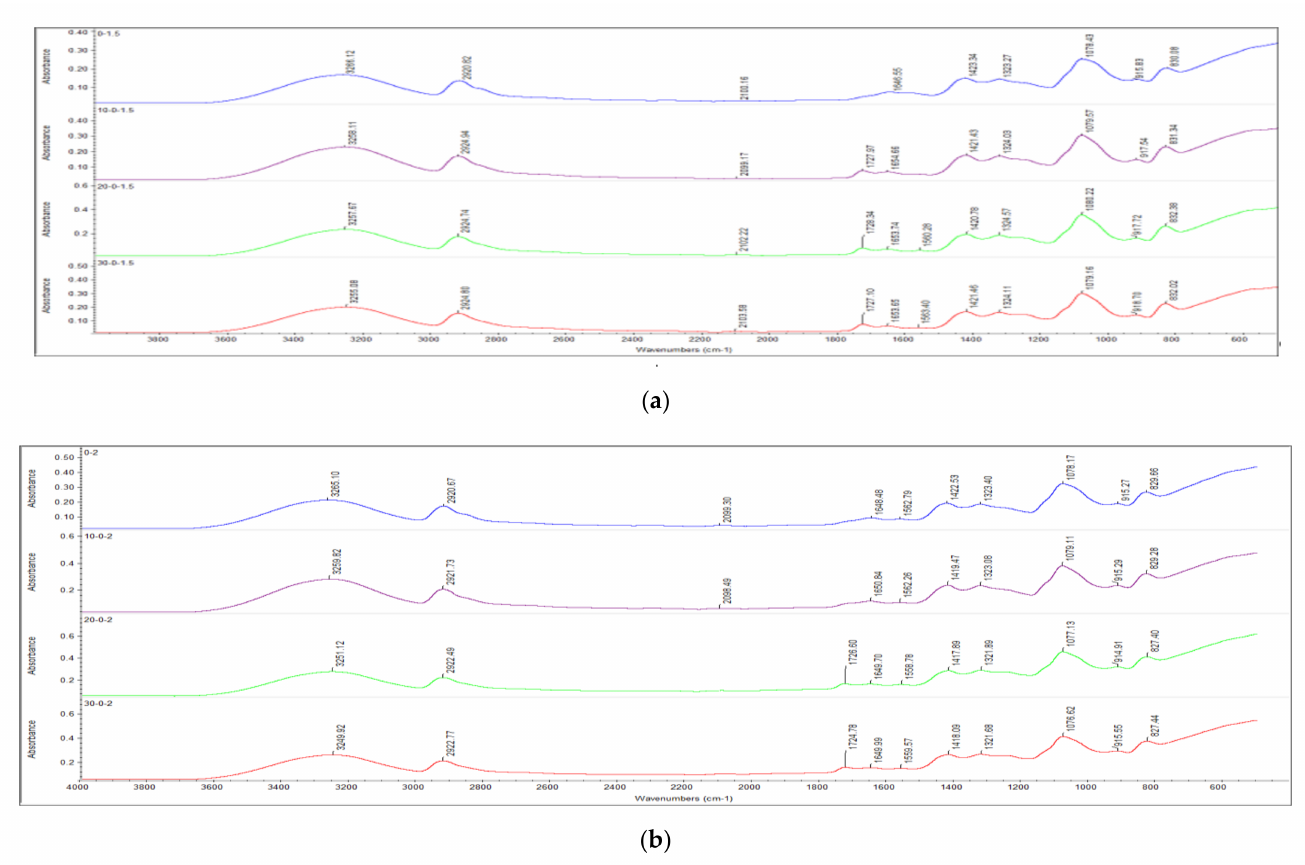
Figure 4. Effects of increasing electron beam irradiation dosages on FTIR spectrum of ( a ) 1.5 phr CNTs and ( b ) 2.0 phr CNTs added polyvinyl alcohol (PVOH)